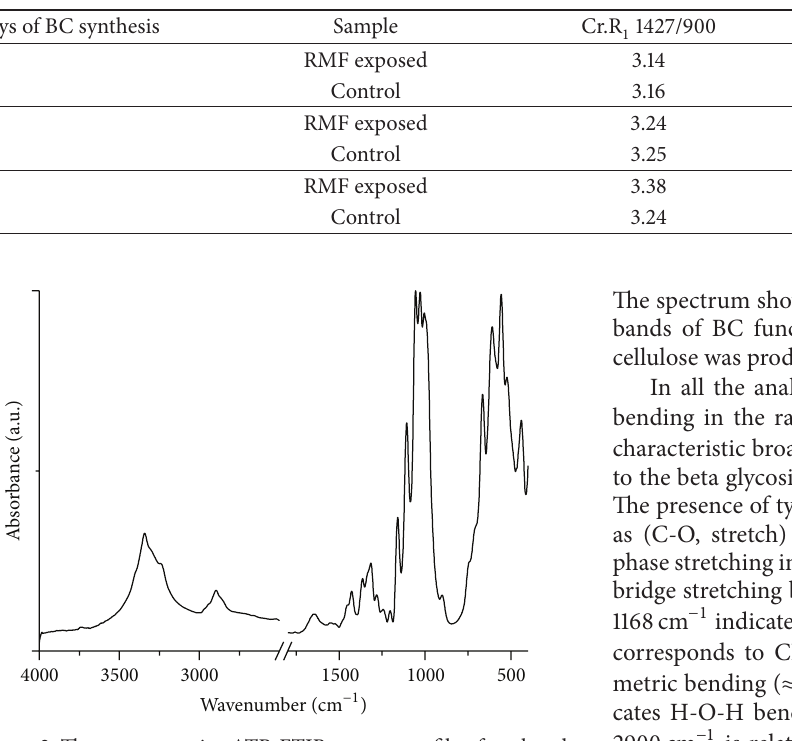
Figure 2: The representative ATR-FTIR spectra profile of analyzed BC samples. The noisy region from carbon dioxide and air influence in range from 2000 cm −1 to 2500 cm −1 was excluded from the